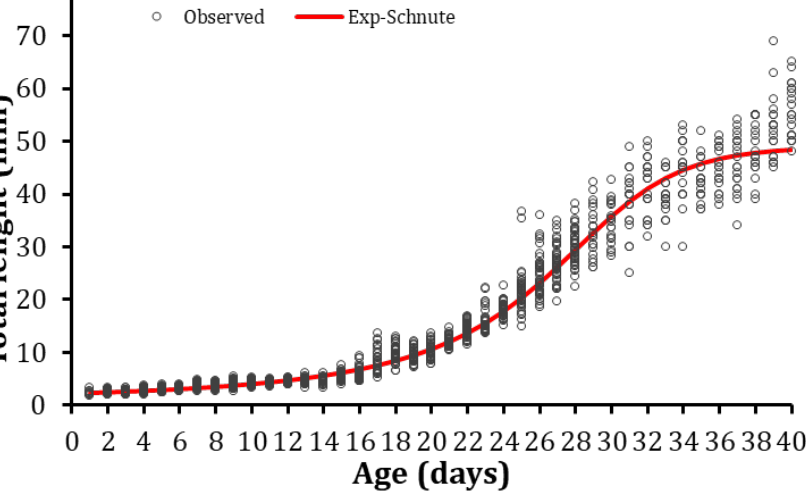
Figure 2. The best-fit model (Exp-Schnute) for observed growth of early stages of Totoaba macdonaldi. Table 2. The Bayesian information criterion (BIC) for each of the ten models. Δ i, differences in BIC; Wi, Bayesian weights.